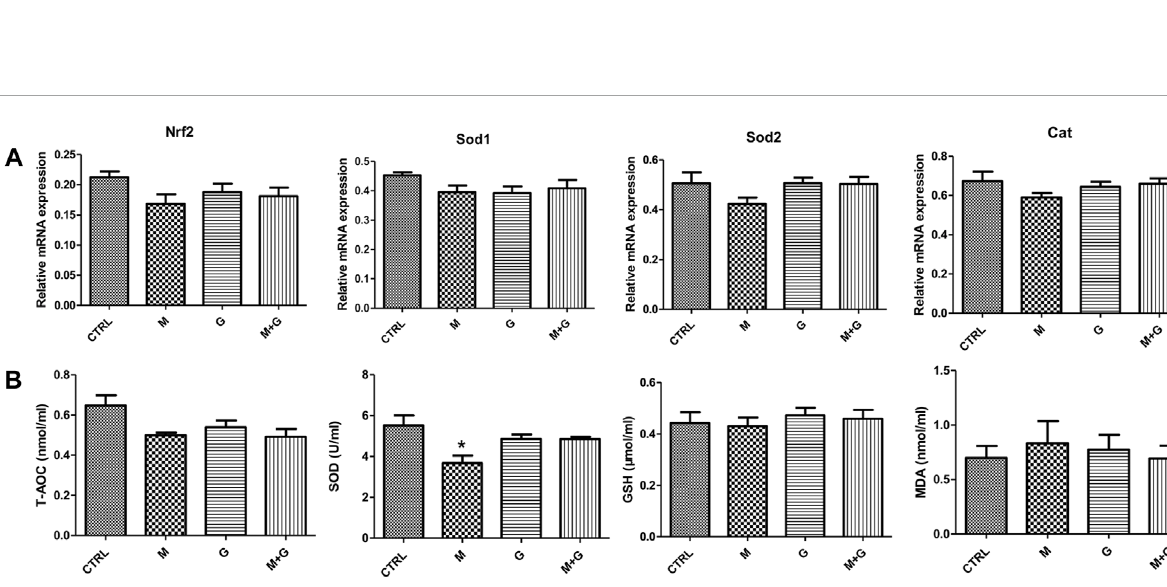
Frontiers in Cell and Developmental